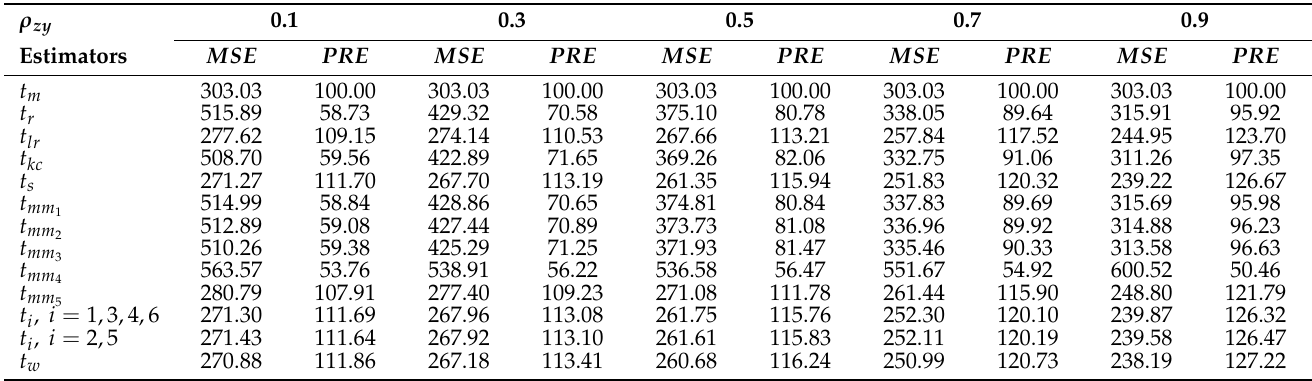
Table 4. MSE and PRE of estimators using uniform